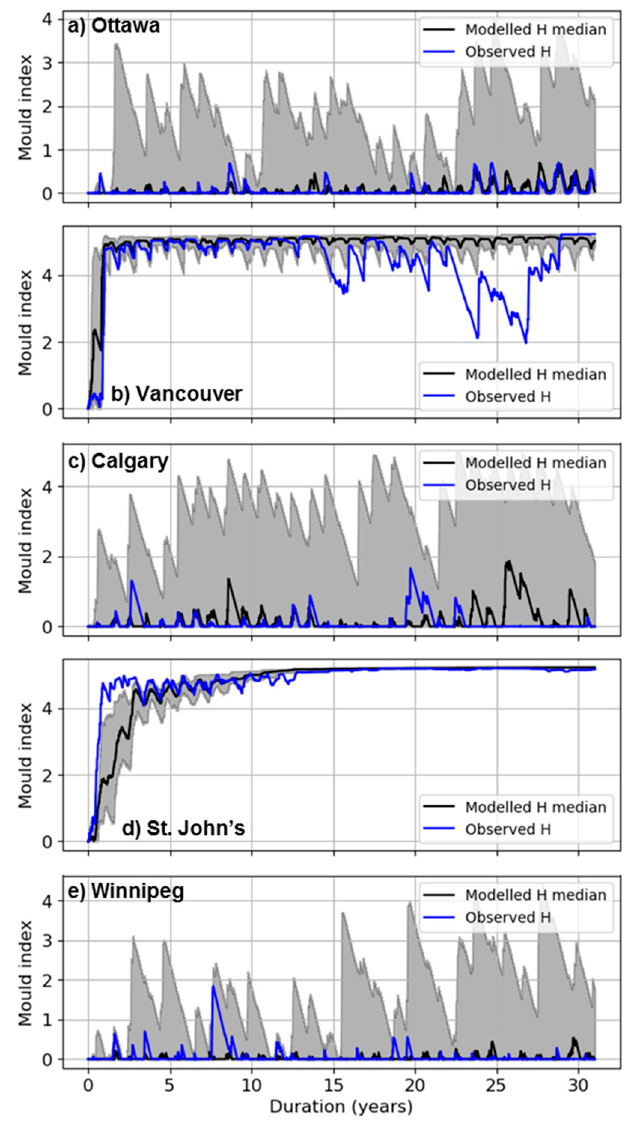
Figure 7. Comparison of mold indexes obtained under historical modeled and observed climates in the cities of Ottawa, Vancouver, Calgary, St. John’s and Winnipeg.